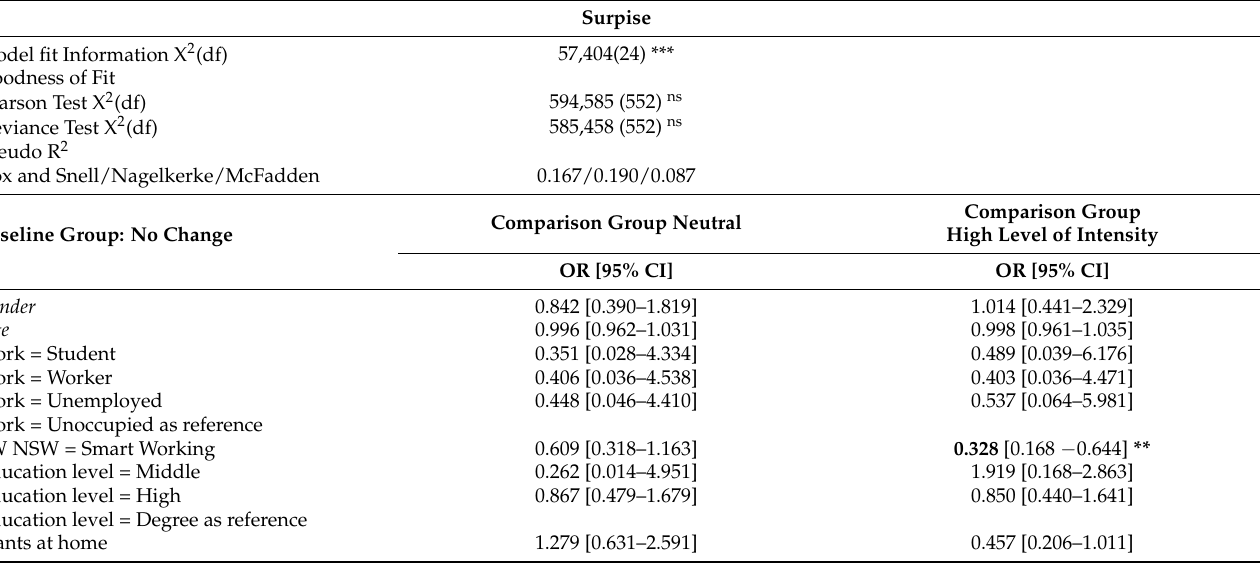
Table A2. Multinomial logistic model for